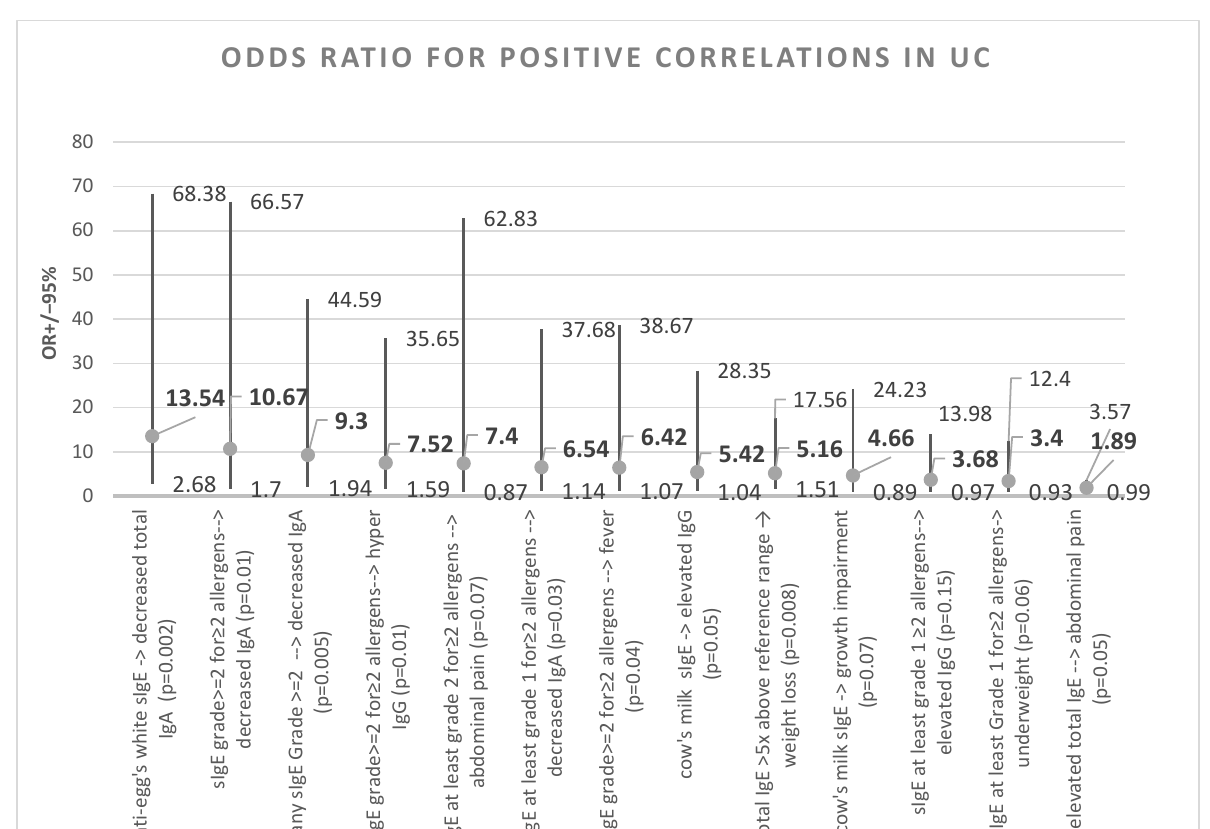
Figure 5. UC correlations.